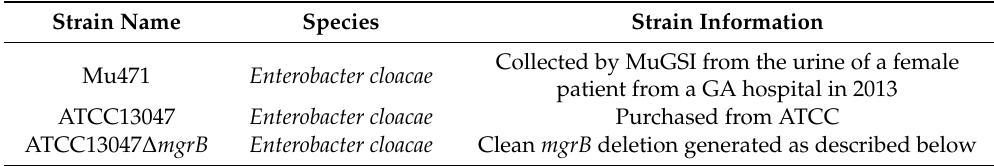
Table 1. Bacterial strains used in this study.